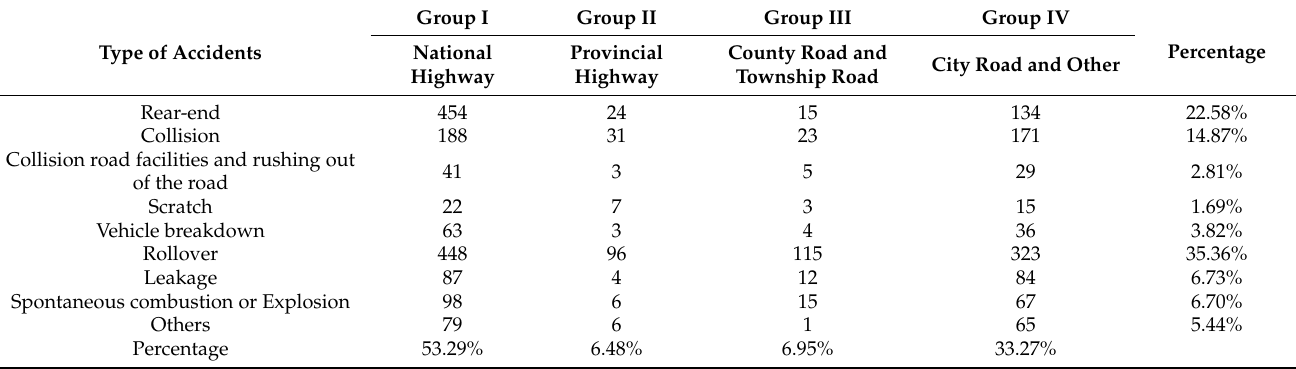
Table 2. The number of accidents by type and road